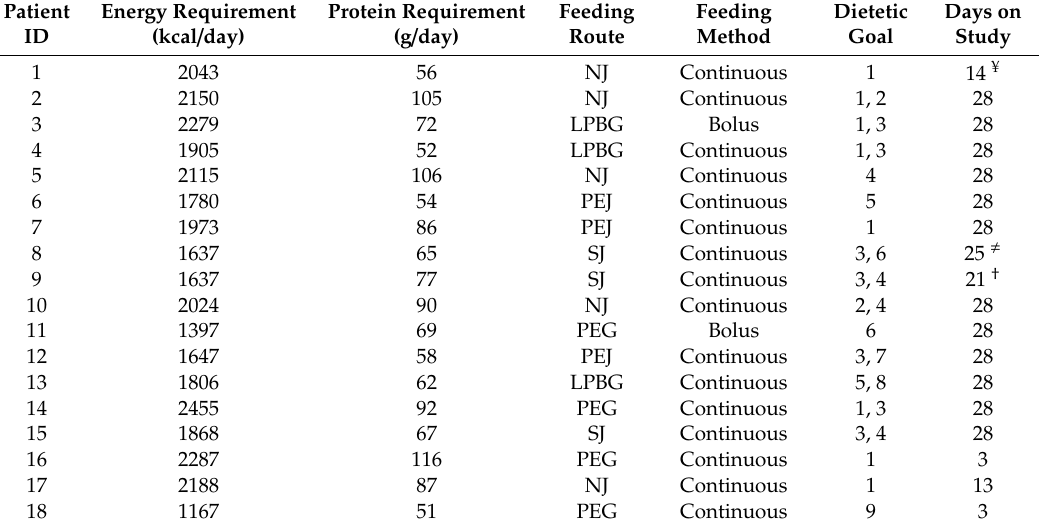
Table 3. Baseline patient characteristics: energy requirement (kcal / day), protein requirement (g / day), feeding route, feeding method, dietetic goal and days on